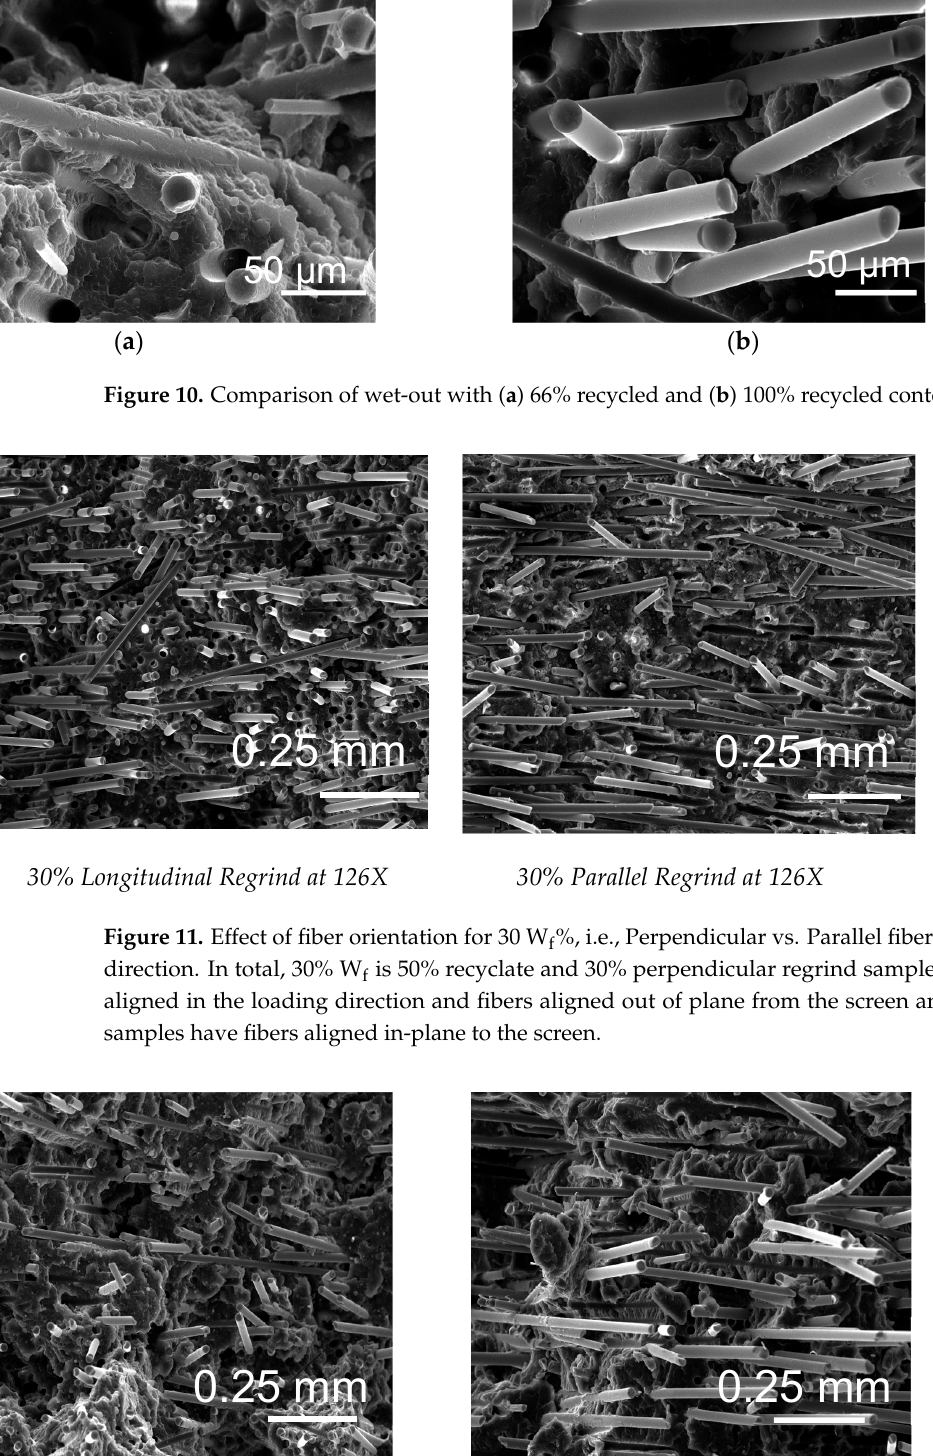
Figure 12. The 30% LFT sample has longer fibers at the tensile breakage surface (higher tensile strength) than 30% regrind sample.